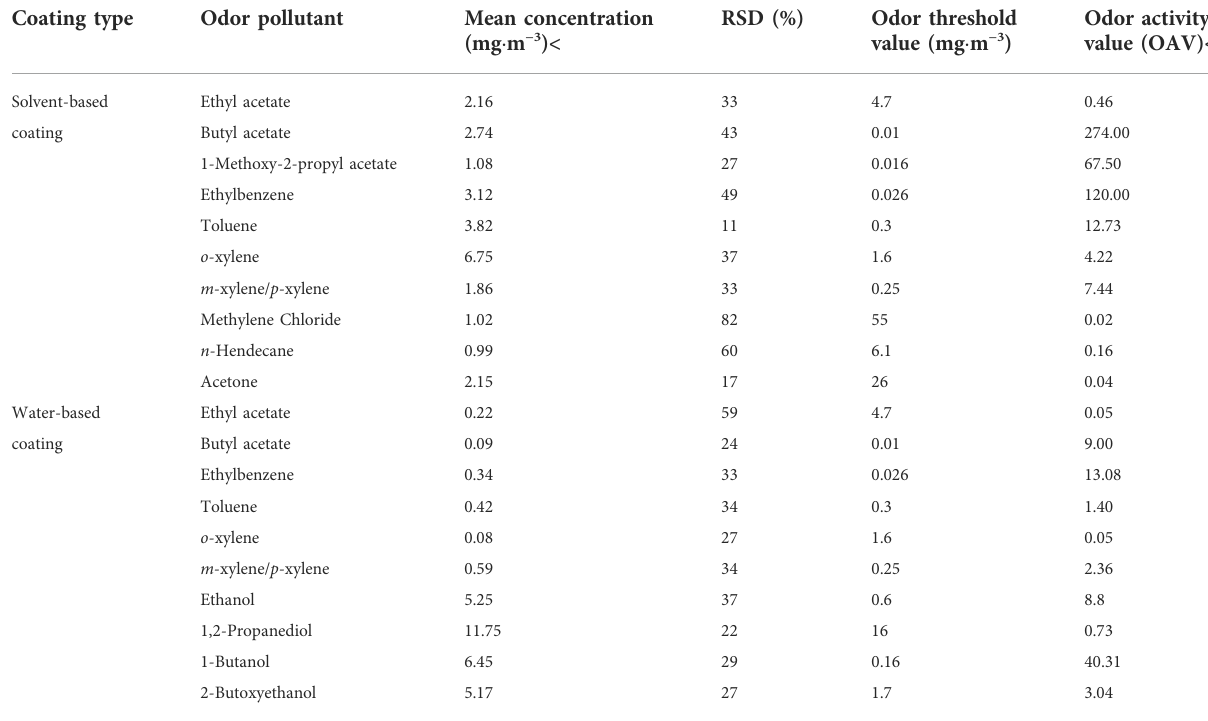
TABLE 4 Concentrations and OAV of VOCs emitted from coating